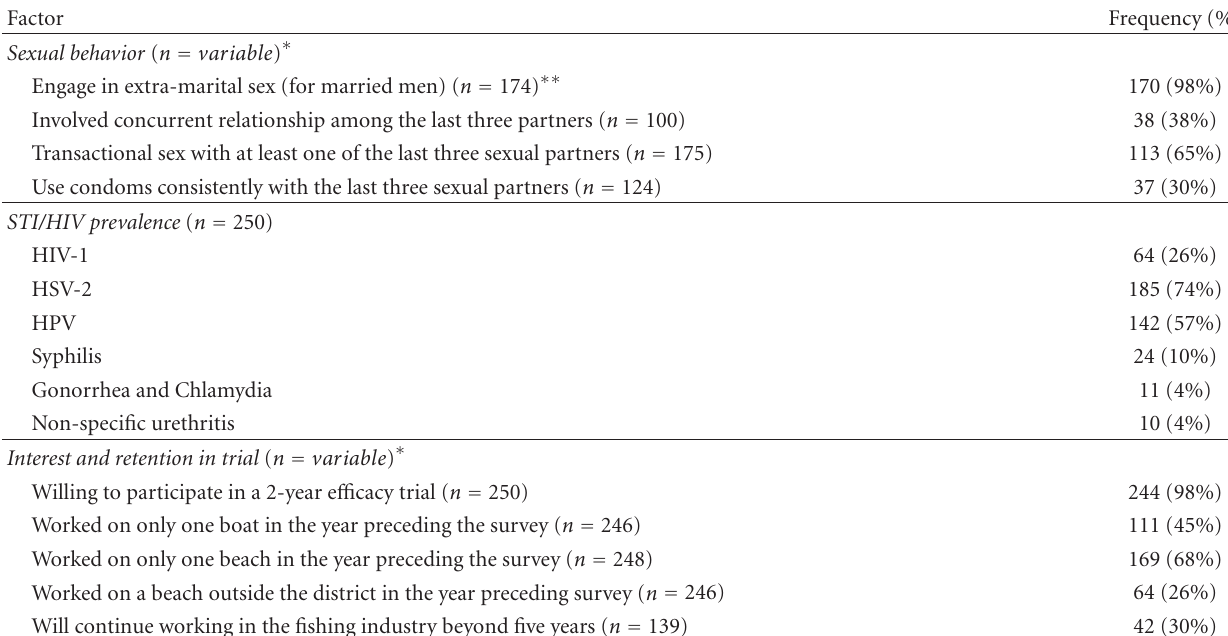
Table 2: Factors depicting fishermen along Lake Victoria in Kisumu as a suitable population for a male microbicide